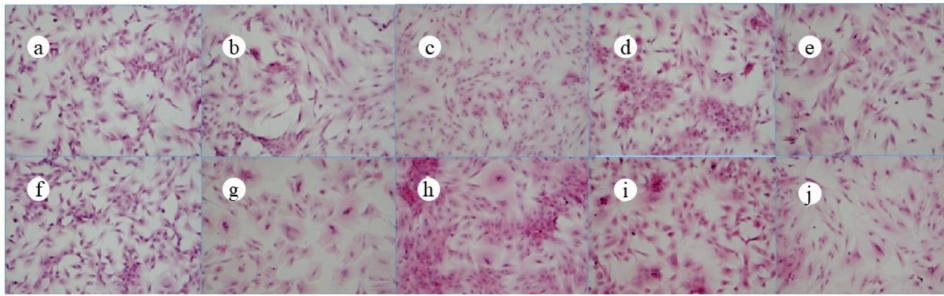
Figure 5. HE staining photos of ADSCs at different times ( a – e : the jawbones scaffold group; f – j : the control group) ( × 40).